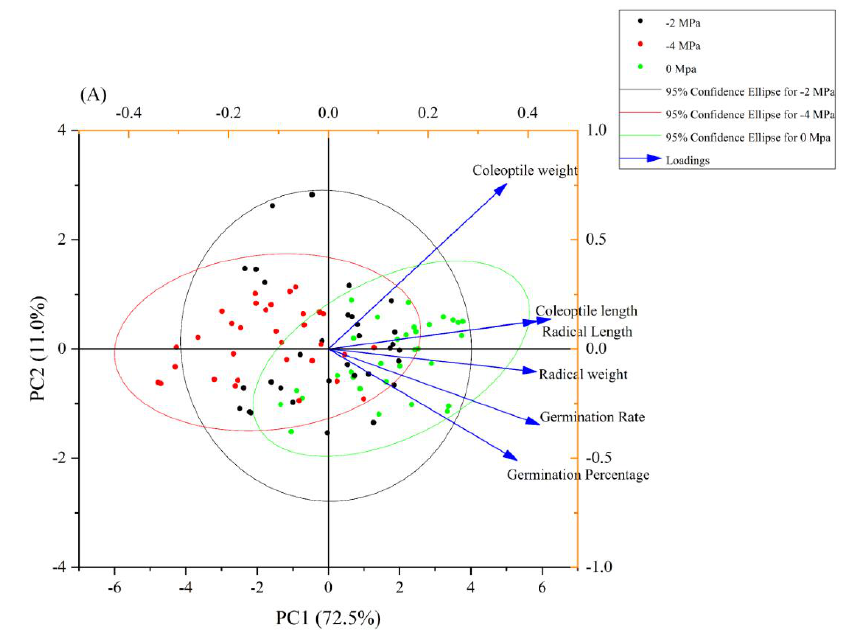
Figure 7. Pearson correlation between germination characteristics in wheat varieties.